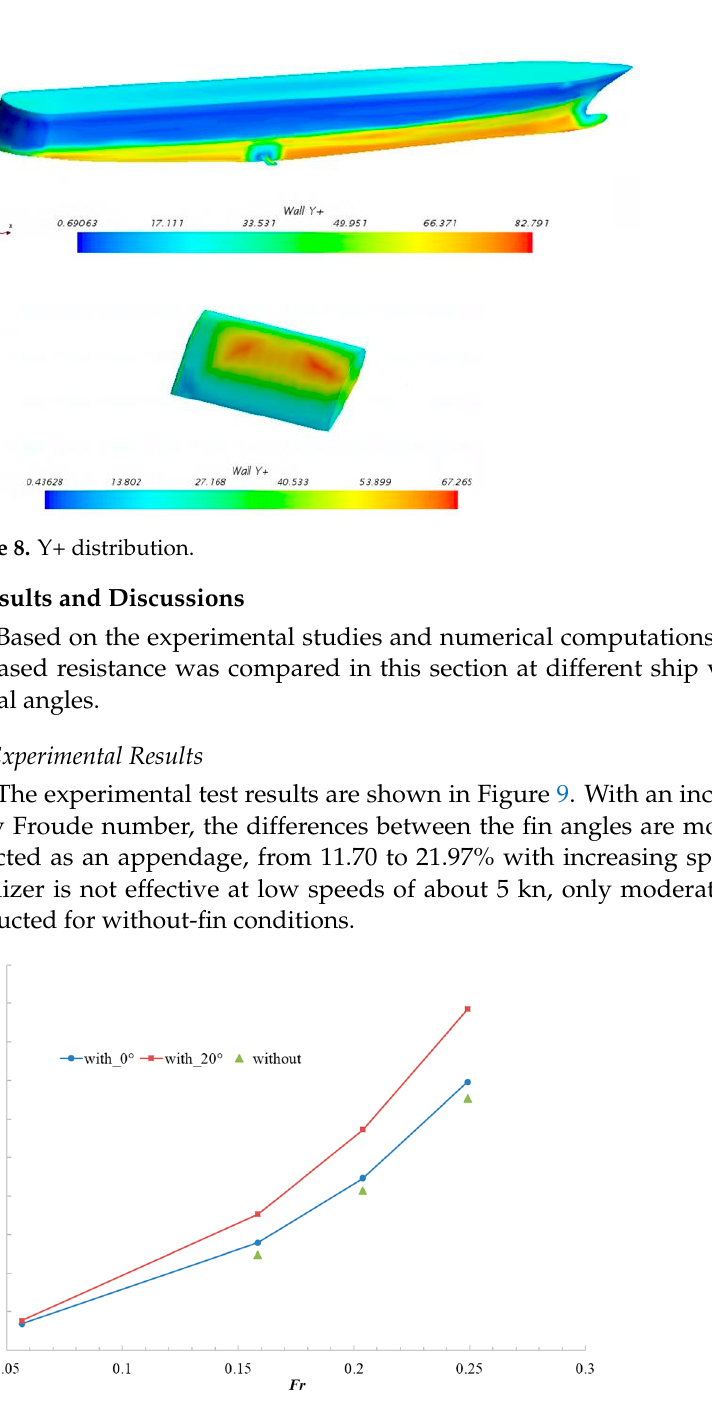
Figure 9. Resistance test data at a different Froude number Fr. Table 4. The resistance increment ratio of model tests with fins at different speeds (o = without).